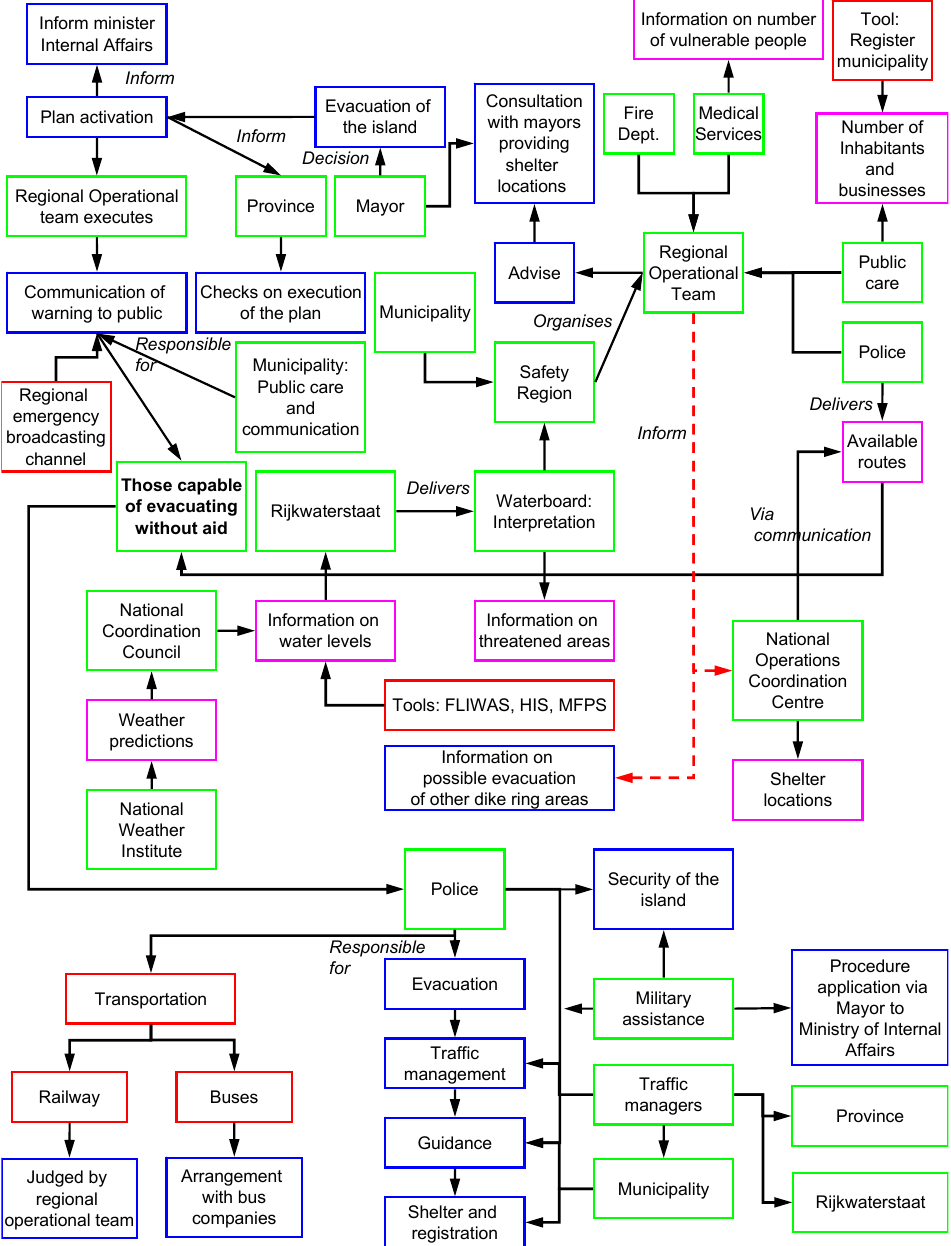
Fig. 10. Entity diagram evaluating the topic relating to the evacuation of people from the Island of Dordrecht, developed during the workshop.